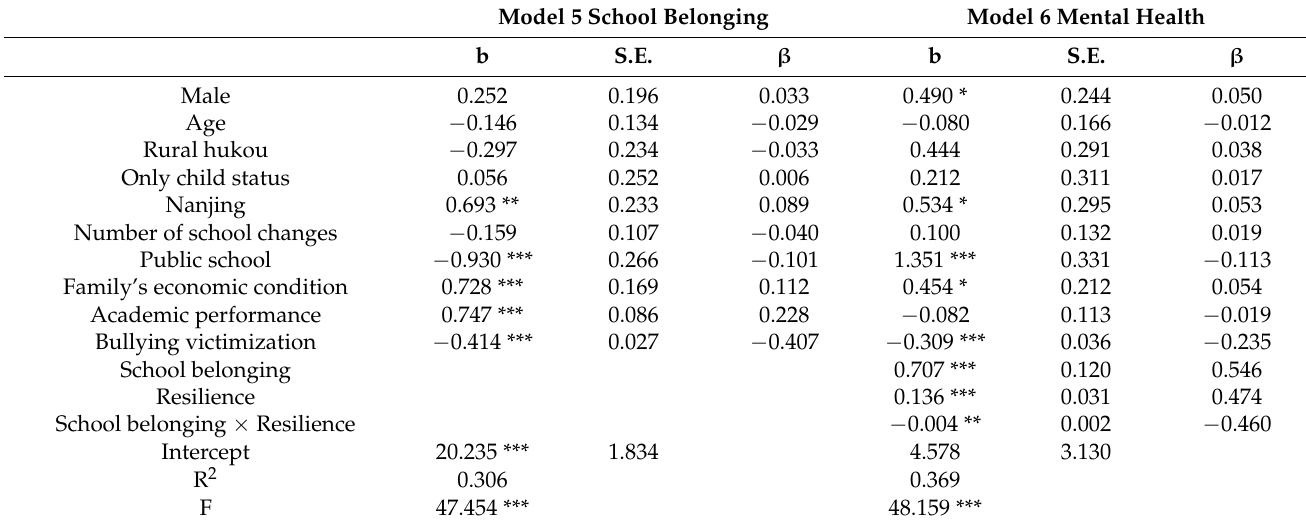
Table 6. Results of moderated mediation analysis.